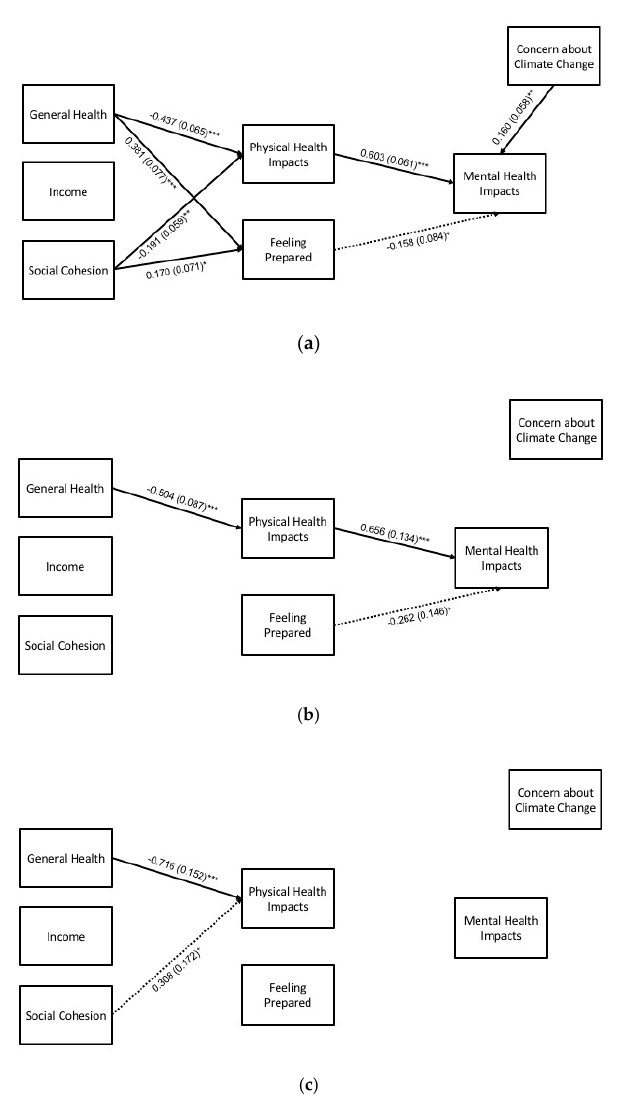
Figure 3. Path model for mental health impacts during summer heat (N = 426), by racial subgroup: ( a ) White ( n = 308), ( b ) Black ( n = 89), and ( c ) other ( n = 29) participants. Statistically significant pathways are shown with standardized estimates and standard errors (SEs) in parentheses. Statistical significance levels are: + p < 0.10, * p < 0.05, ** p < 0.01, and *** p < 0.001.